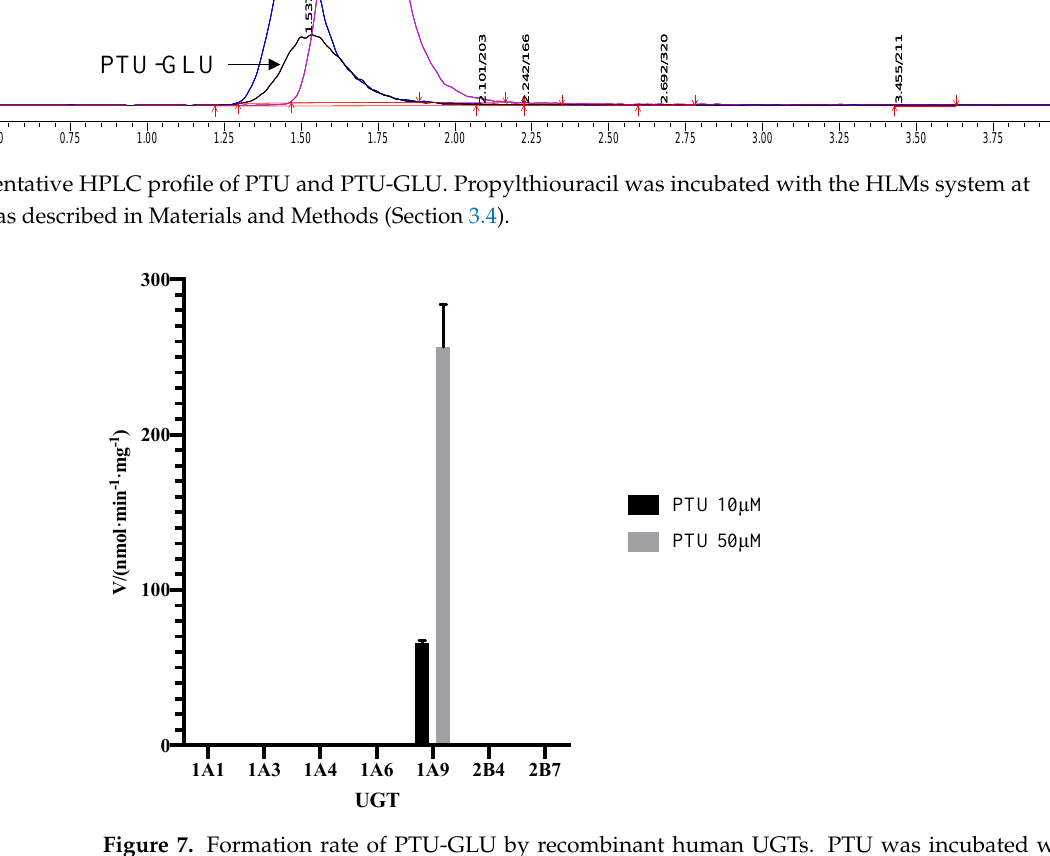
Figure 7. Formation rate of PTU-GLU by recombinant human UGTs. PTU was incubated with different UGTs at 37 °C for 60 min as described in Materials and Methods (Section 3.4). Each point represents the average of three replicates.